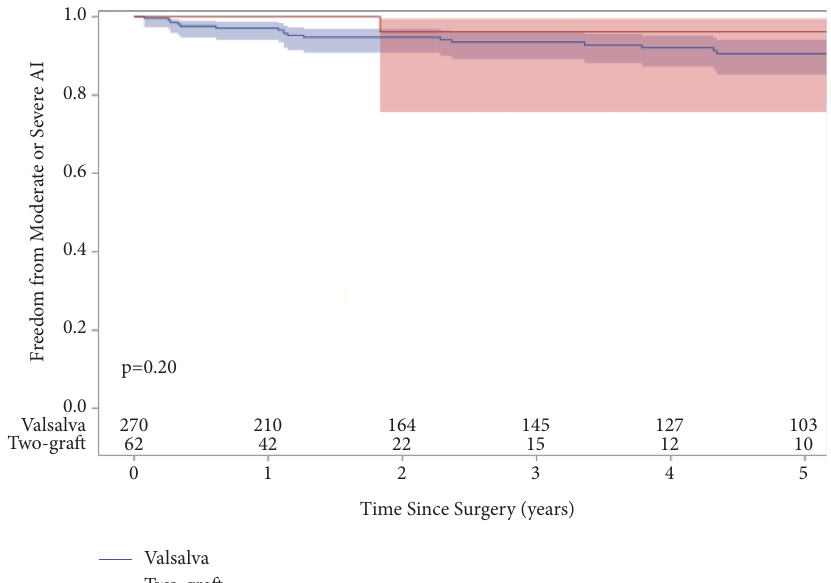
Figure 4: Kaplan–Meier freedom from moderate and severe aortic insufciency of valve-sparing aortic root replacement patients who underwent David-V-Valsalva (5-year: 91%) or David-V-Smod (5-year: 96%) techniques ( p � 0 .